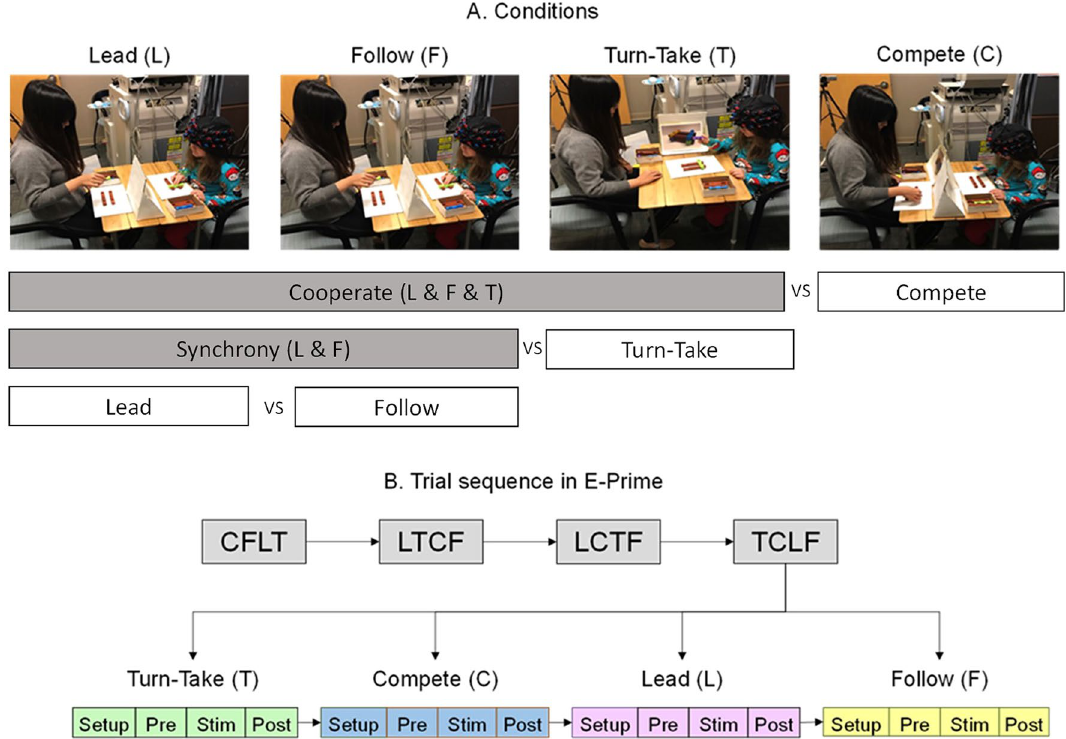
Figure 6. Experimental conditions of Lead, Follow, Turn-take, and Compete ( A ), and the randomized blocked design protocol for the dyadic task ( B